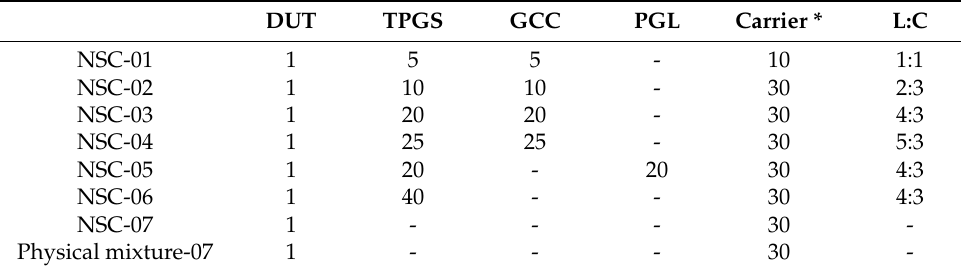
Table 1. Composition ratio of components in NSCs (%, w / w